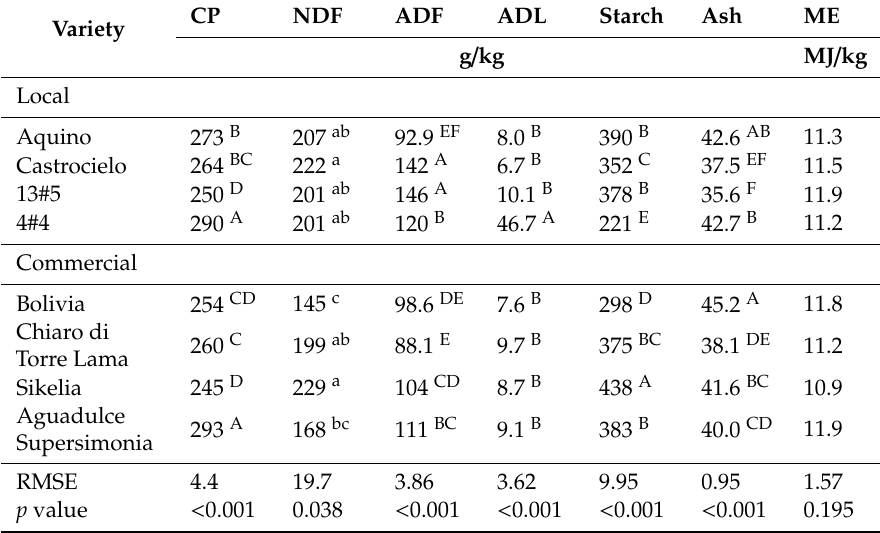
Table 2. Chemical composition on dry matter basis of faba bean